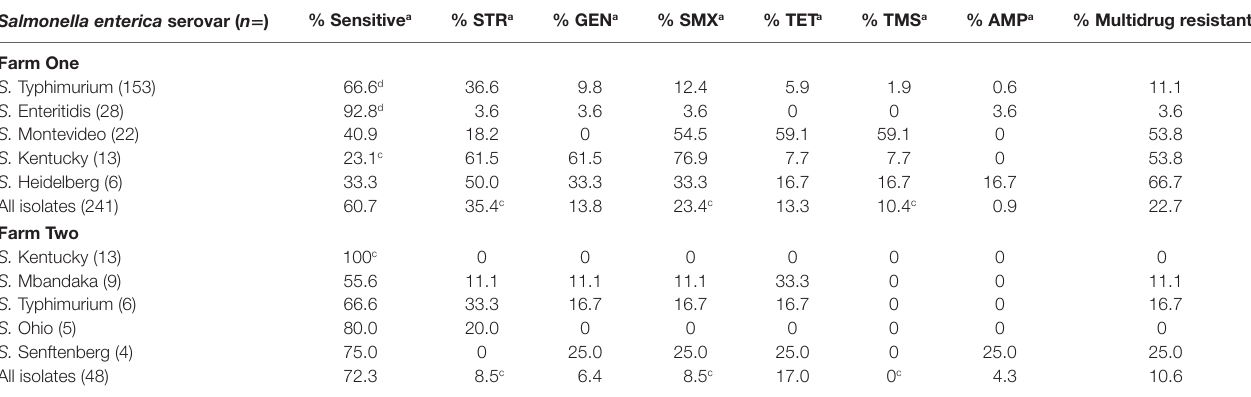
TaBle 1 | Most prevalent antimicrobial resistance phenotypes observed in the Salmonella serovars isolated from production and processing of seven consecutive commercial broiler flocks. Salmonella enterica serovar ( n = ) % sensitive